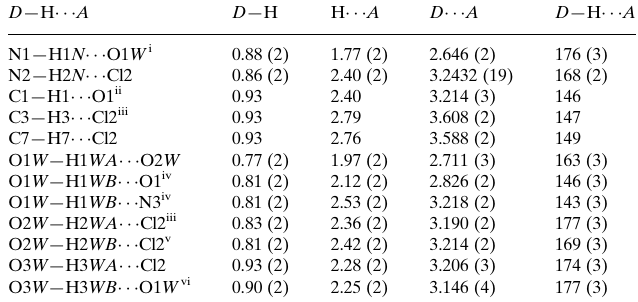
Hydrogen-bond geometry (A˚ , (cid:4)